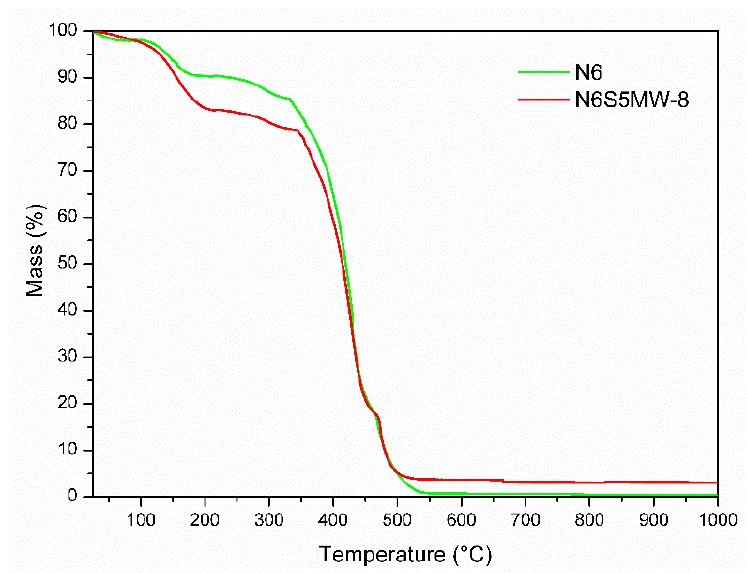
Figure 11. TG curves of samples N6 and N6S5MW-8.